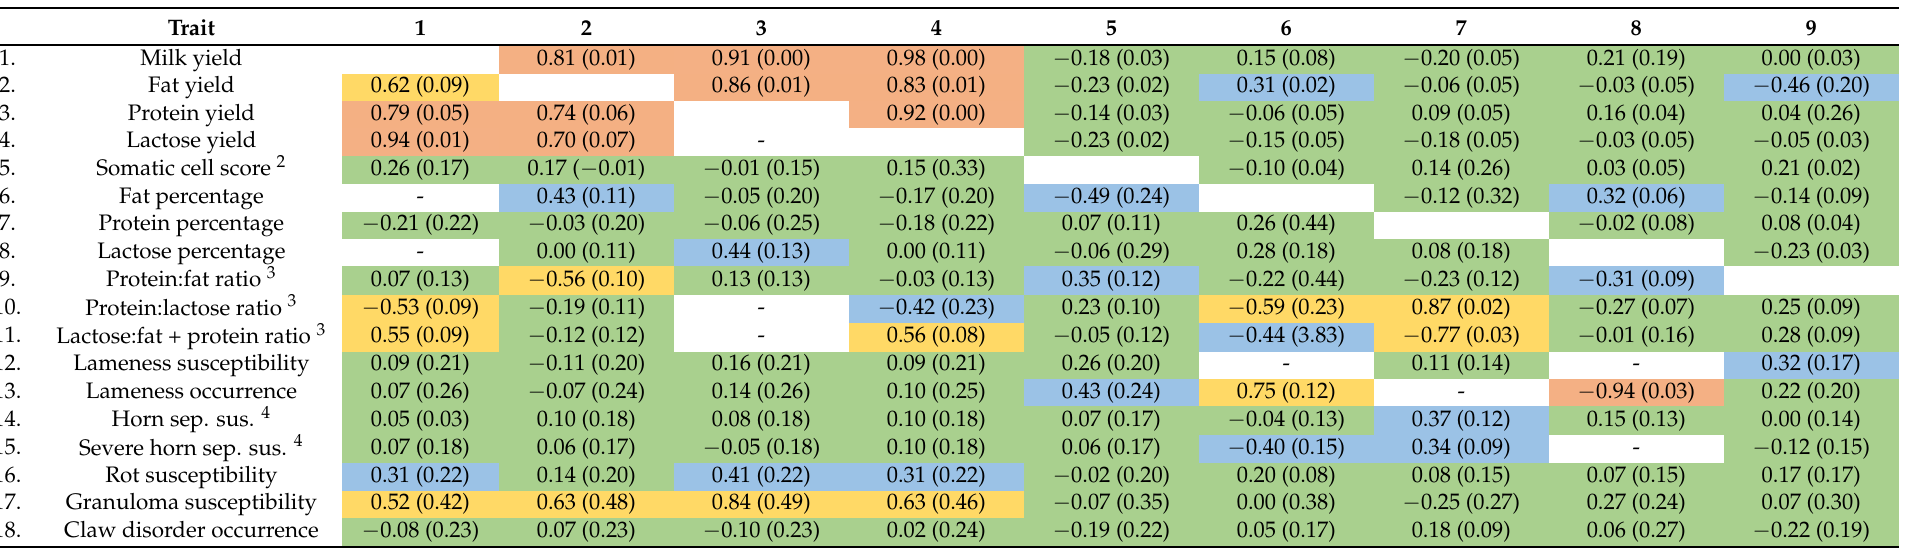
Table 3. Estimates of phenotypic (above diagonal) and genetic (below diagonal) correlations 1 and standard errors (in parentheses) for milk production, lameness, and claw disorder traits in dairy goats from three farms within New Zealand collected between July 2019 and June 2020 production